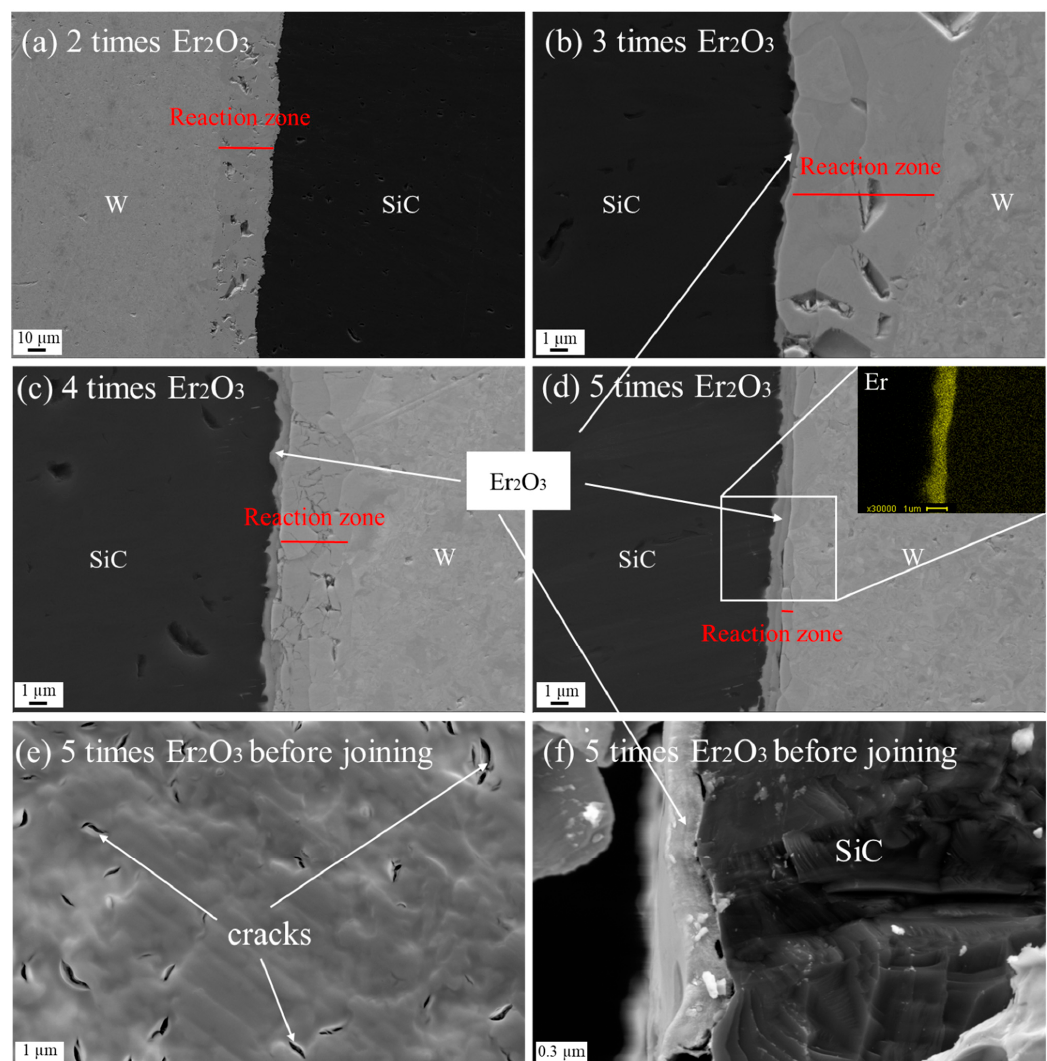
Figure 6. SEM images of surface and cross-section of coated CVD-SiC before and after joining with W foils. Images ( a – d ) are the cross-section of 2-times to 5-times dipped Er 2 O 3 -coated SiC joined with W, respectively; ( e ) is surface of Er 2 O 3 coating by 5-times dipping before joining; ( f ) is cross-section of Er 2 O 3 coating by 5-times dipping before joining.